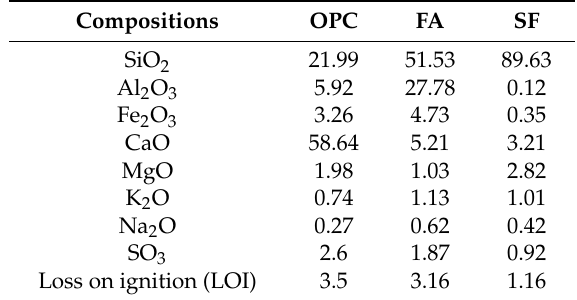
Table 1. Chemical composition of ordinary Portland cement (OPC), fly ash (FA), and silica fume (SF). Compositions